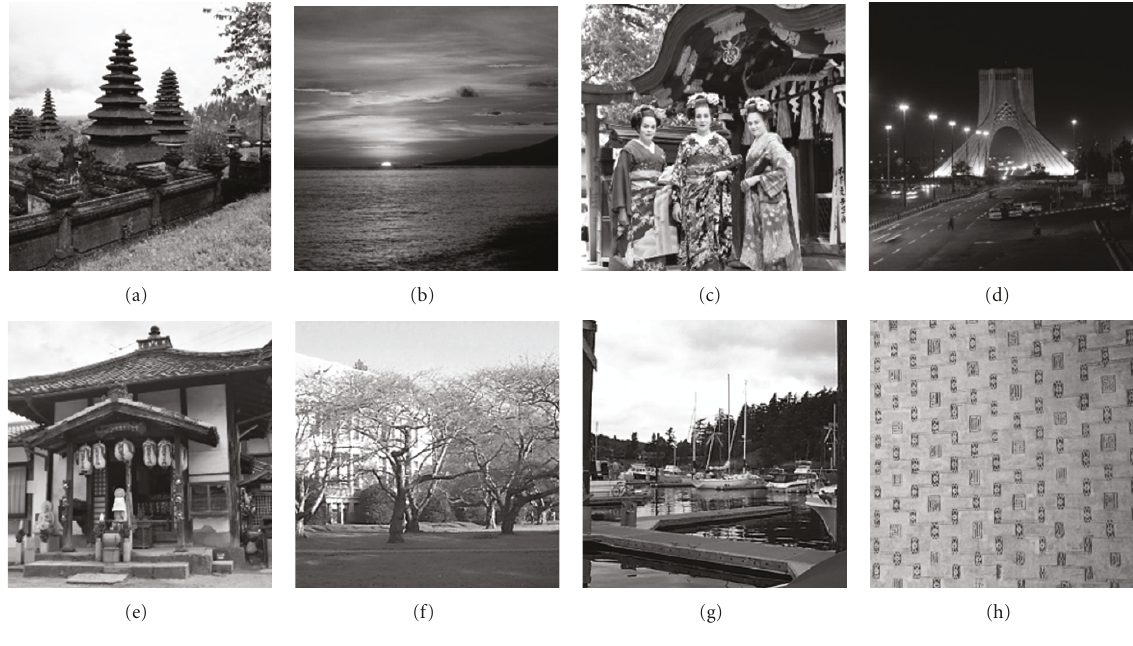
Figure 2: Some example